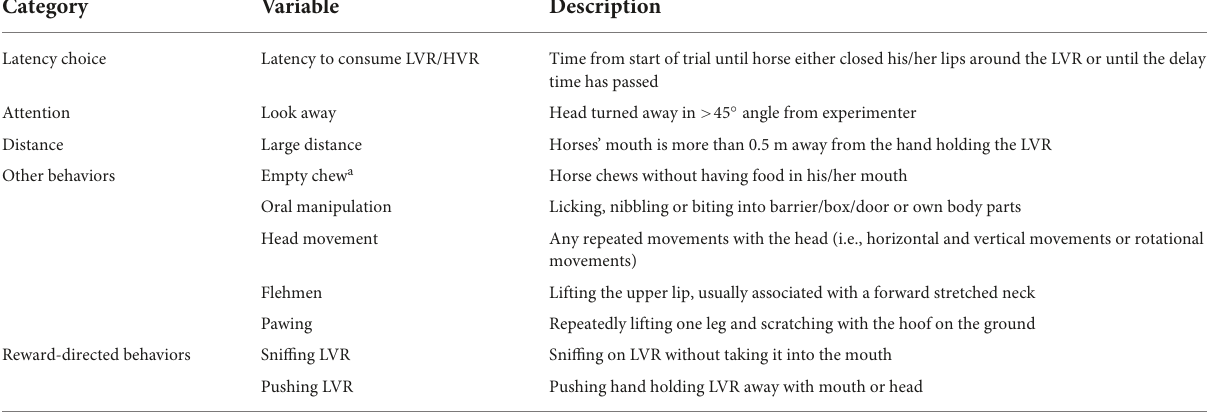
TABLE 3 Ethogram of coded behaviors. Category